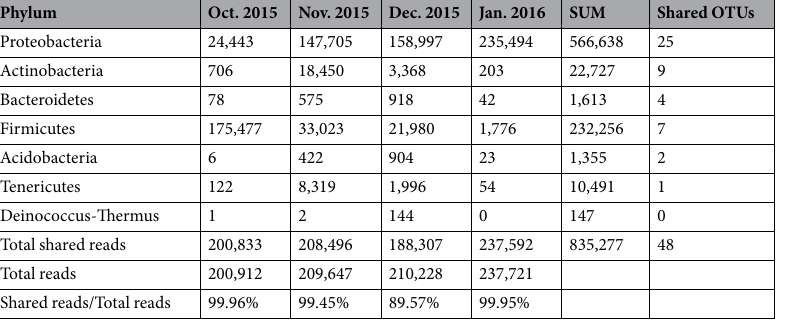
Table 2. Shared seven phyla communities of Dendroctonus armandi larvae from October 2015 to January 2016. OTU,operational taxonomic